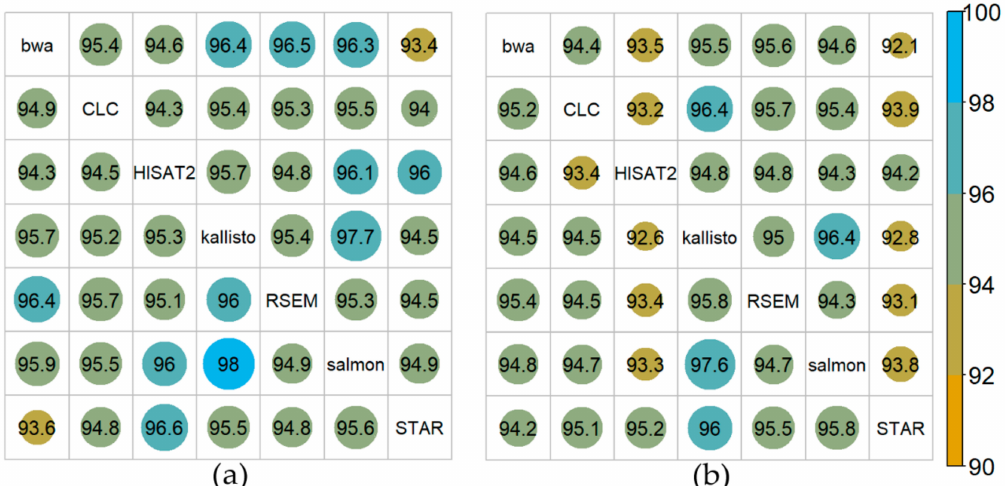
Figure 5. Overlap of significantly di ff erentially expressed genes among the di ff erent mappers for cold acclimated vs control plants. Overlap in % for Col-0 ( a ) and N14 ( b ). DGE was determined at FDR p < 0.1 and an absolute log 2 FC > 1 using the R-package DESeq2 . Overlap of di ff erentially expressed genes among each pair of mappers is represented in an asymmetric matrix.